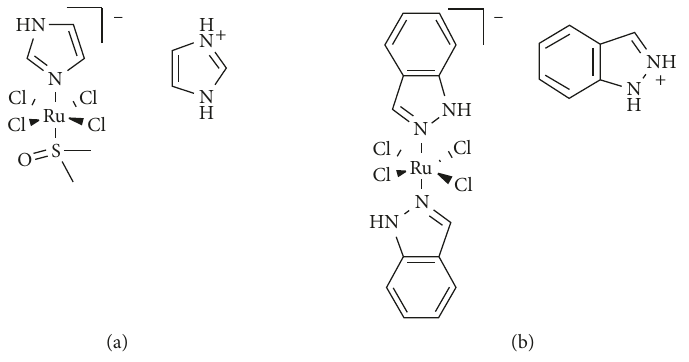
Figure 1: Structures of (a) NAMI-A and (b)